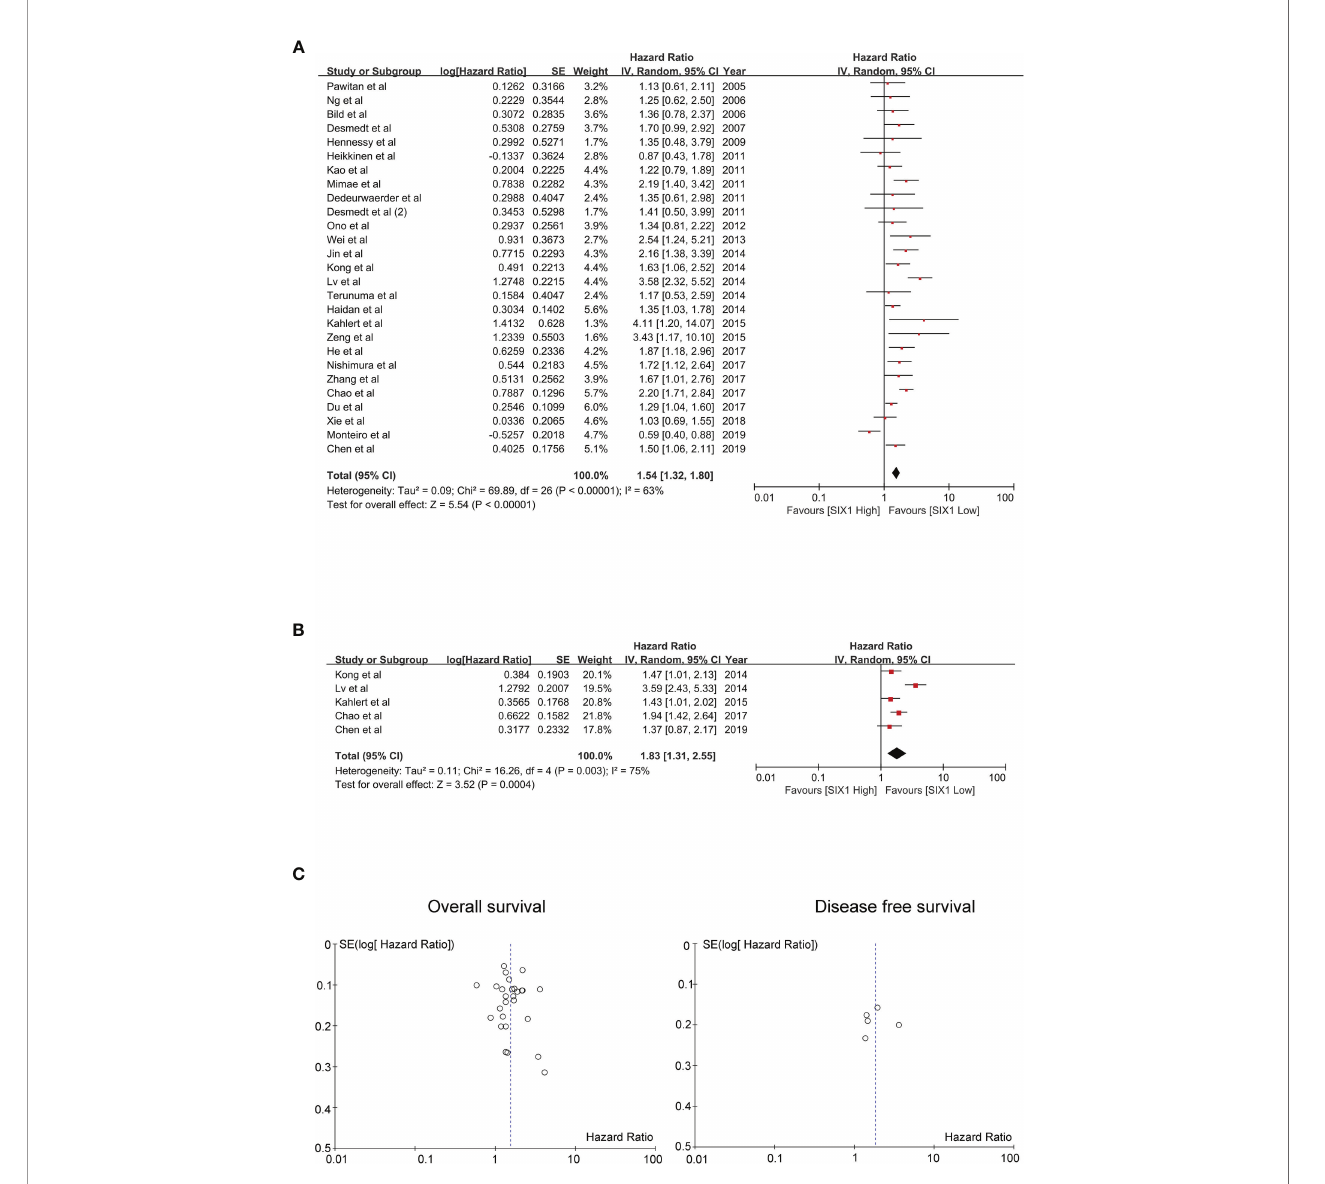
FIGURE 2 | Evaluating HRs of SIX1 expression and the prognosis of cancer patients. (A) Forest plot of studies evaluating high expressed SIX1 and the OS; (B) Forest plot of studies evaluating high expressed SIX1 and the DFS; (C) Funnel plots of studies evaluating OS (left) and DFS